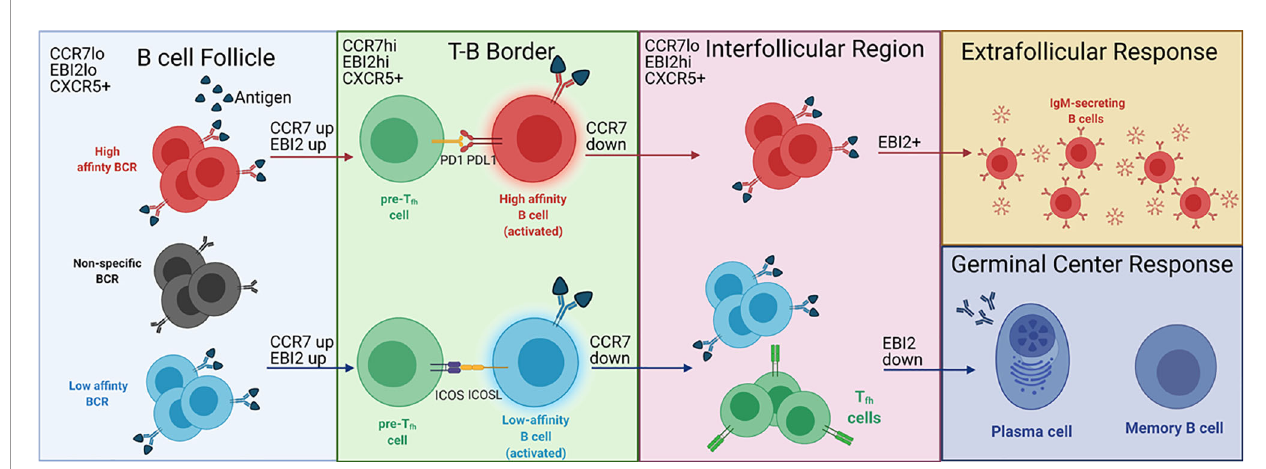
FIGURE 1 | BCR af fi nity controls EF versus GC B cell development at the T-B border. Antigen binding naïve B cells in the B cell follicle migrate to the T-B border after upregulating CCR7 and EBI2. B cells that do not bind antigen (black) cannot migrate to the T-B border. At the T-B border, B cells with high af fi nity BCRs (red cells) are PDL1 hi , allowing for PDL1-PD1 interactions with pre-Tfh cells (green cells). B cells expressing low af fi nity BCRs (blue cells) show stronger ICOS-ICOSL interactions with pre-Tfh cells, which induces Tfh differentiation (green cells expressing TCR in the interfollicular region). After interacting with pre-Tfh cells at the T-B border, B cells downregulate CCR7 and migrate to the interfollicular region. B cells with high af fi nity BCRs maintain EBI2 expression and participate in the EF response. B cells with low af fi nity BCRs downregulate EBI2 and enter the GC, leading to the production of long-lived plasma cells and memory B cells. The labels on the top left of each region depict the B cell expression pro fi le of chemokine receptors that regulate localization to the respective region. This is not speci fi ed for the EF and GC responses as the expression of the chemokine receptors for each response is unclear. Adapted from reference